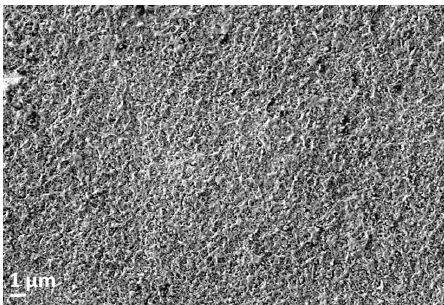
Figure 10. SEM micrography of a film deposited from a 0.2 M (in Y) SDP precursor ink with a 10% ( v / v ) of the UV varnish and [DEA]/[Y] ratio of 4.5.